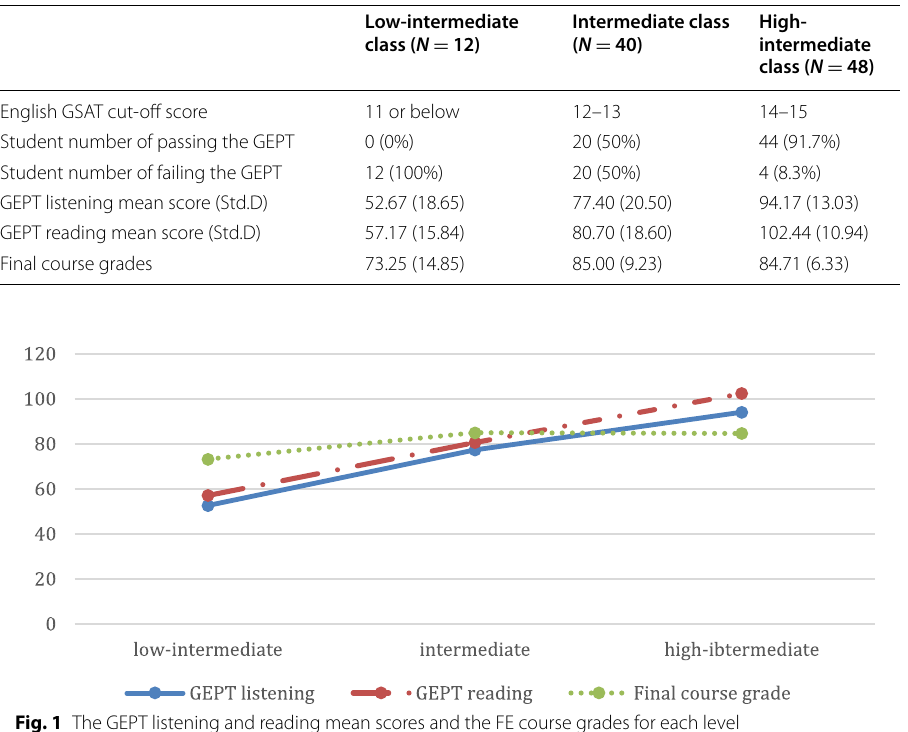
Fig. 1 The GEPT listening and reading mean scores and the FE course grades for each